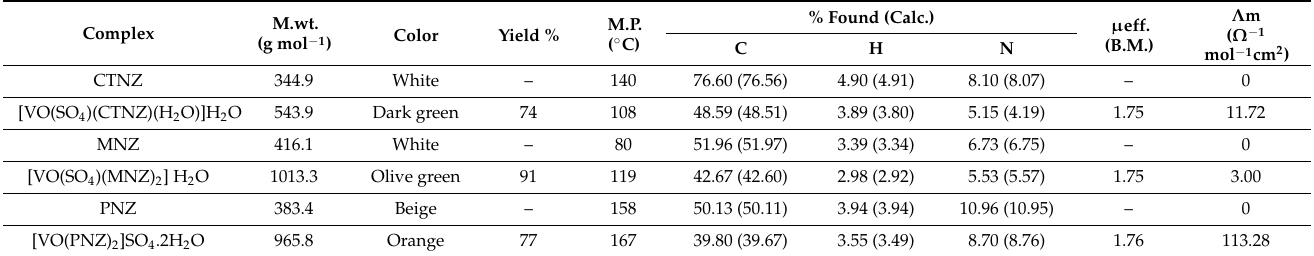
Table 1. Analytical and physical data of ligands and their oxidovanadium(IV) complexes.